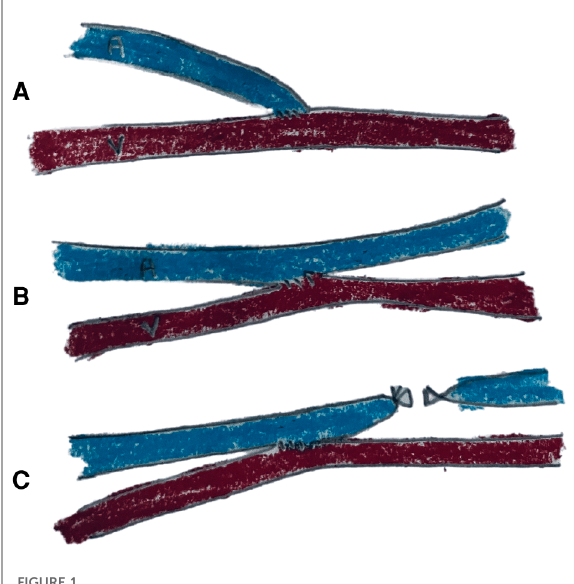
FIGURE 1 Schematic diagram showing ( A ) ETS ( B ) STS ( C ) STS with distal vein